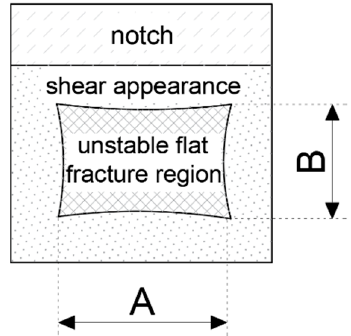
Figure 8. Flat fracture region with partially cleavage cracked zone (partially bri tt le) and surrounding shear generated fracture area.